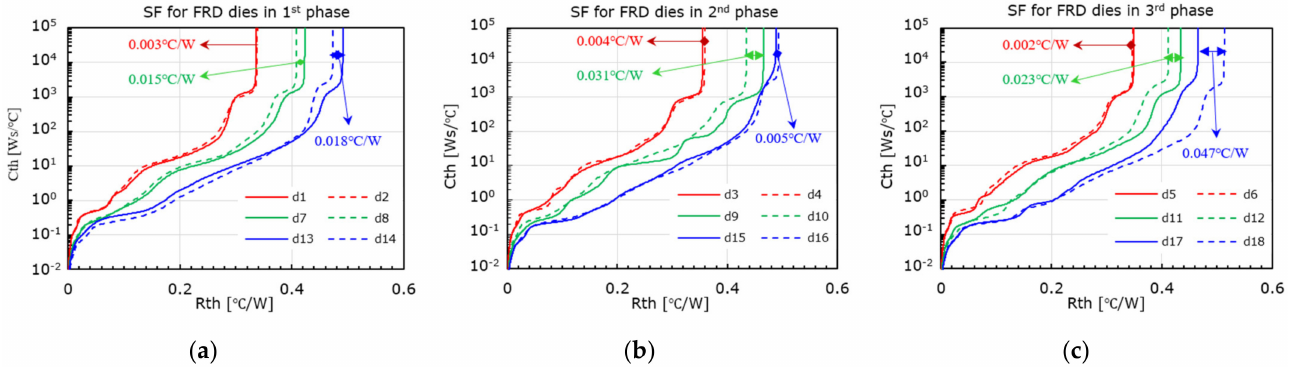
Figure 5. SFs of heat-flow paths for the measured anti-parallel FRD dies under heating current of 100 A: ( a ) 1st phase, ( b ) 2nd phase, ( c ) 3rd phase. The solid and dashed lines represent the SFs of the upper side and lower side, respectively, while the red, green and blue lines are standard for GM_2, GM_1, and boost,